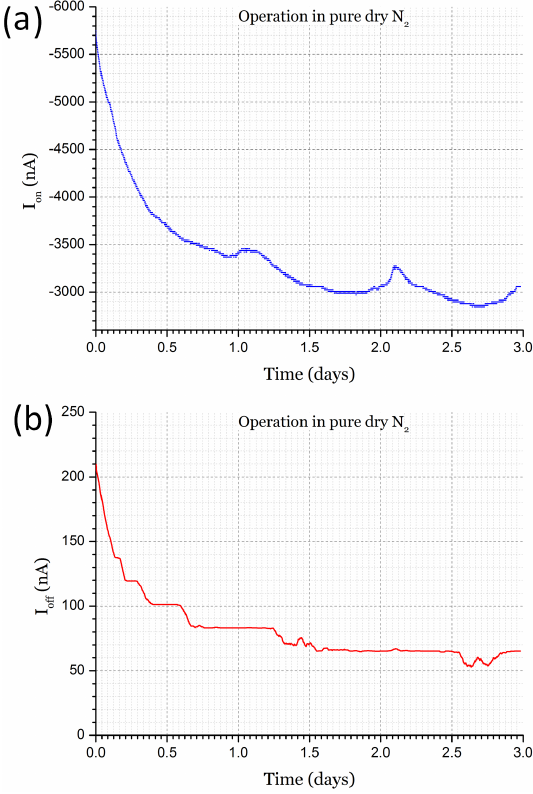
Figure 3. (a) Maximum drain current ( I ON ); (b) minimum drain current ( I OFF ) for a PBTTT OTFT under nitrogen purge over the course of 3 days. Data for V DS = V GS =− 20V( I ON ), V DS = V GS = + 20V( I OFF ).